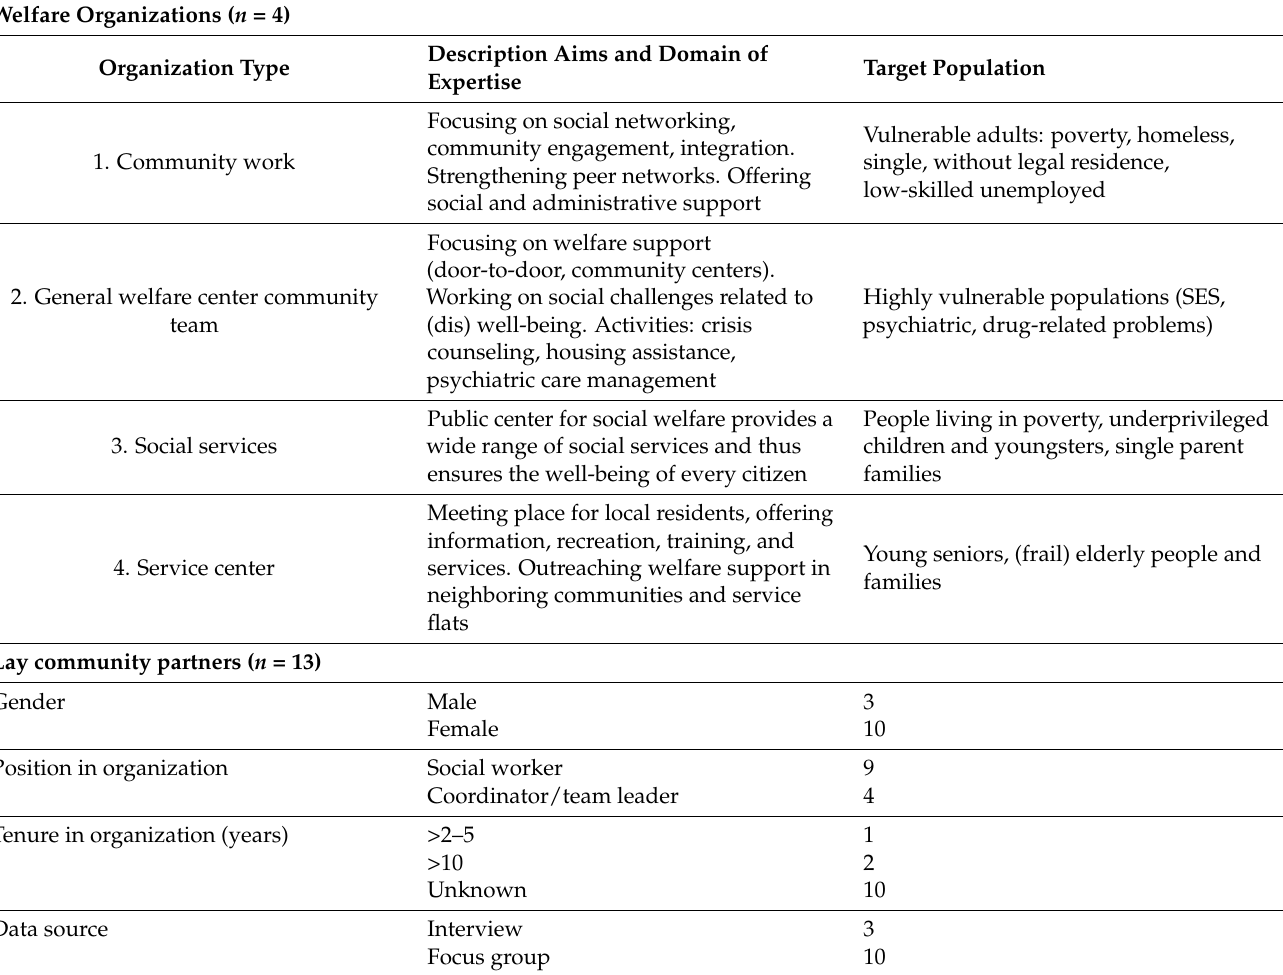
Table 3. Phase 2 welfare organization and lay community partner